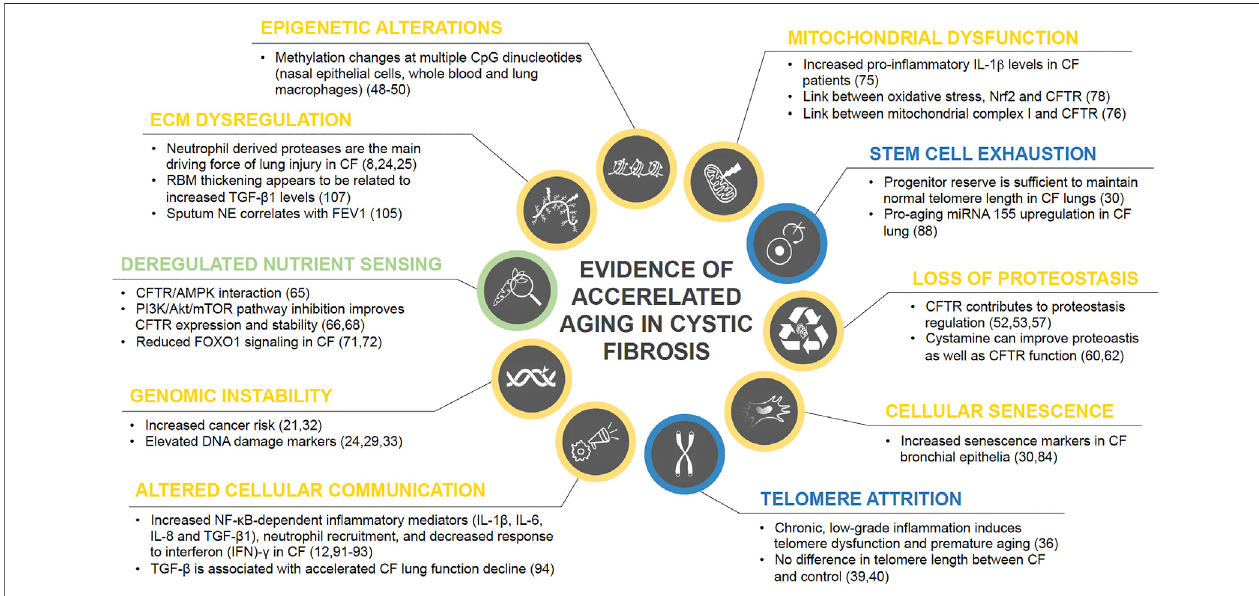
FIGURE 1 | Current state of evidence on accelerated aging processes in CF. Research fi ndings on the role of each of the ten hallmarks of aging in CF disease are summarizedandcolorcodedbasedontheirlevelofevidencewithblue (cid:1) noevidenceforinvolvementinCFpathology,green (cid:1) weakevidence,yellow (cid:1) strongevidence.